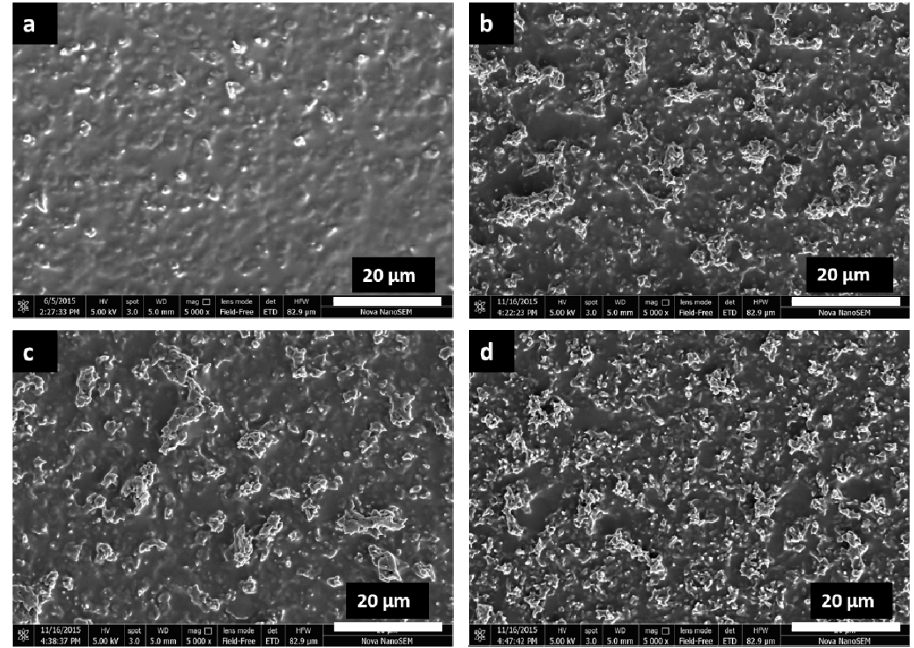
Figure 6. Surface SEM images of composite membranes fabricated with cast coating method: ( a ) pure PVA coating; and PVA ‐ GO hybrid coating with ( b ) 0.1 wt. %, ( c ) 0.2 wt. %, ( d ) 0.3 wt. % GO loading.